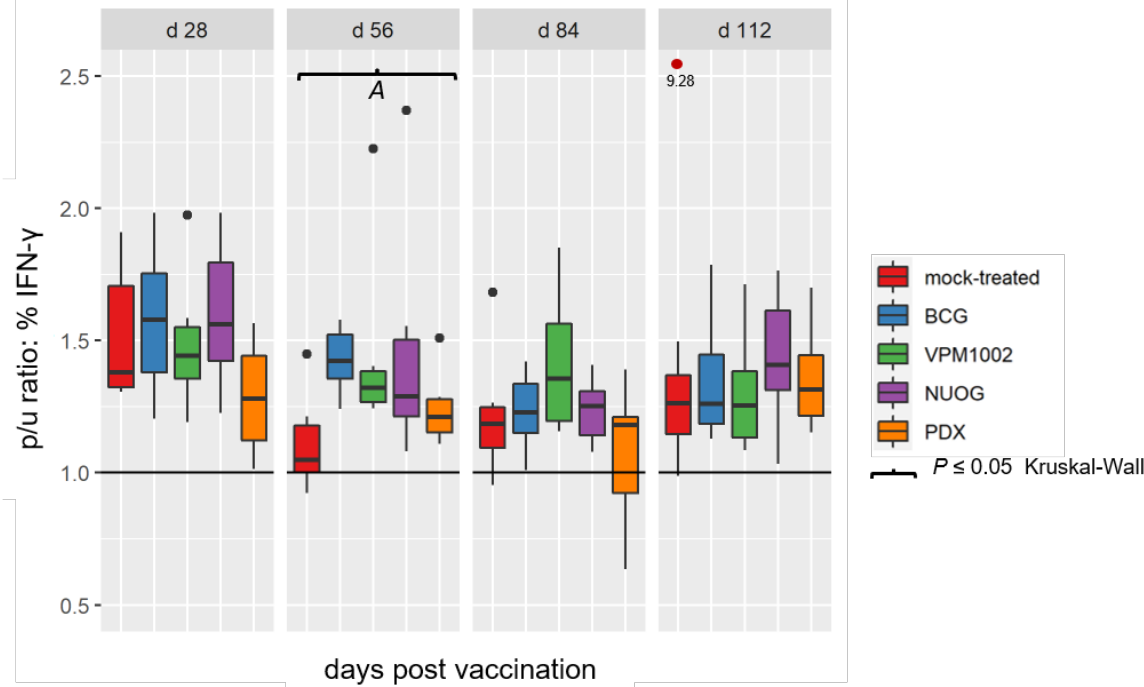
Figure 7. Relative proportion of total lymphocytes containing IFN- γ after in vitro stimulation with bPPD in peripheral blood mononuclear cells (PBMC) cultures derived from goats vaccinated with either BCG, VPM1002, NUOG, PDX or mock-treated. Results are expressed as p/u ratio (cid:104) % bPPD stimulated cells ( p ) (cid:105) % unstimulated cells ( u ) , as described in Materials and Methods. A p/u ratio greater than 1 (hori- zontal line) indicates an increased proportion of IFN- γ + T cells after bPPD stimulation compared to unstimulated cells. ( A ) Cells from VPM1002- and BCG- vaccinated animals responded significantly differently to cells from the mock-treated goats.